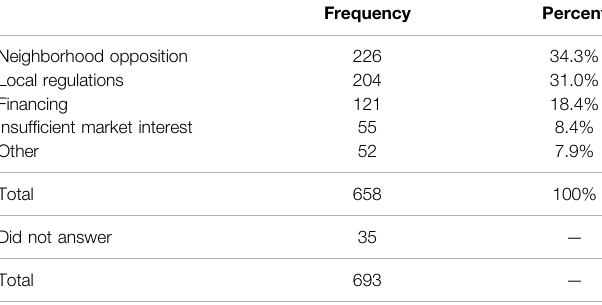
TABLE 5 | Frequency of second most signi fi cant challenge 2004 (Levine and Inam,